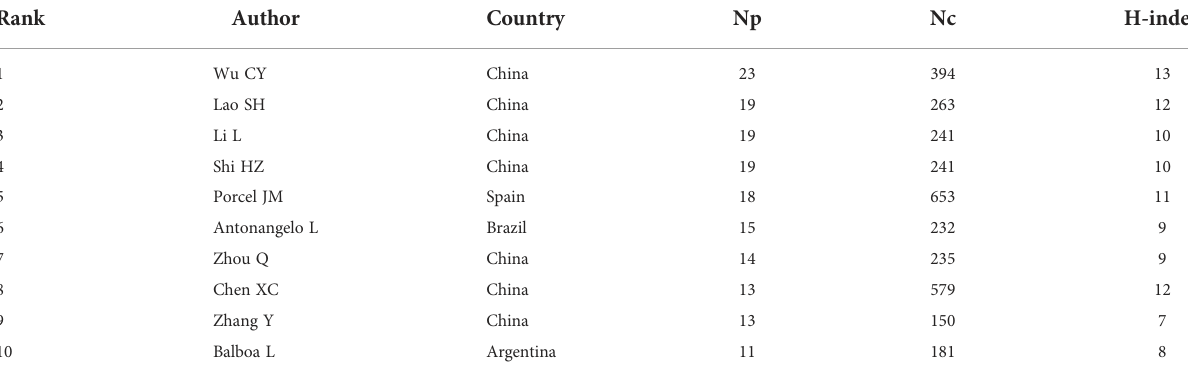
Np, number of publications; Nc, number of